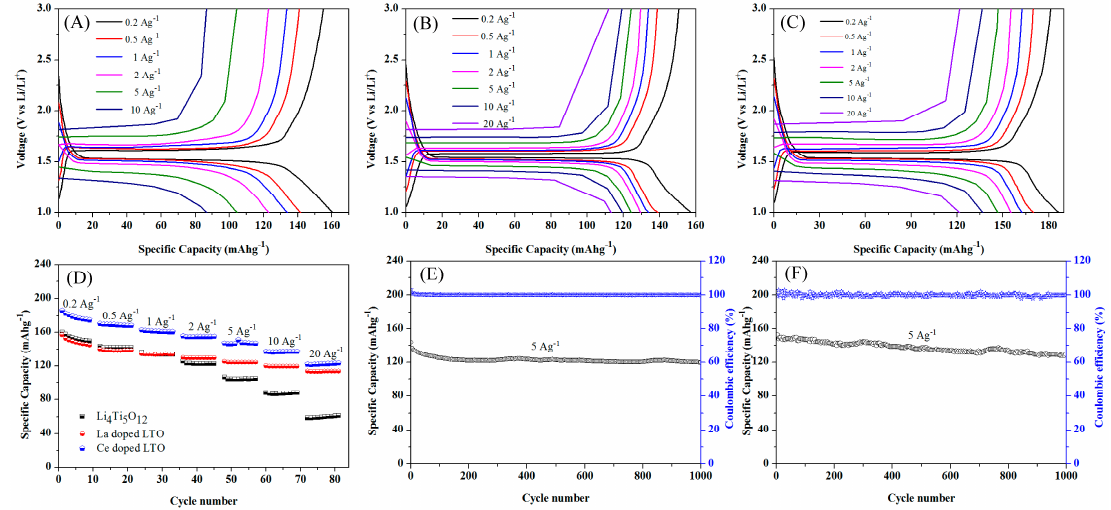
Figure 5. The galvanostatic discharge-charge profiles of pure LTO ( A ), La-doped LTO ( B ) and Ce-doped LTO ( C ) at varied current density; ( D ) Rate performance for these samples ( E ); Cycle performance plots of La-doped LTO ( E ) and Ce-doped LTO ( F ) at 5 Ag − 1 . The pure LTO provided a specific capacity of ~159.7 mAh·g − 1 at the current density of 0.2 Ag − 1 for the initial discharge, while the doped LTO delivered a slightly higher value at the same rate. Even